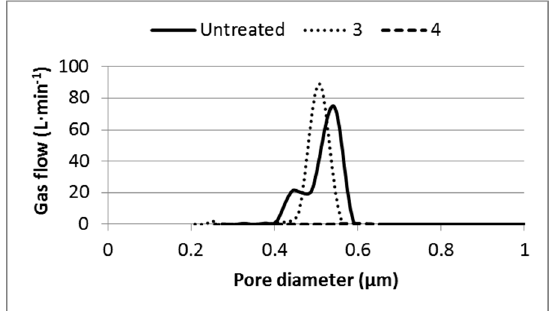
Figure 7. Pore size distribution untreated PES-membrane, membrane 3, and membrane 4 using porometry.